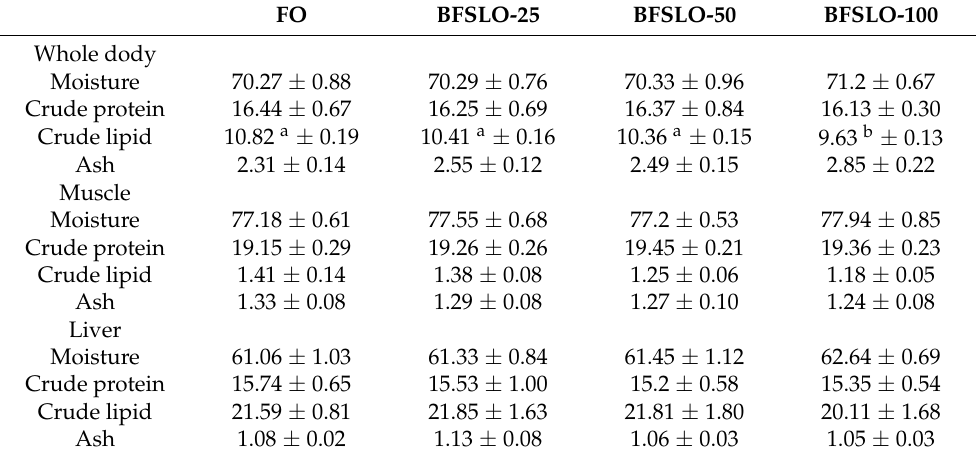
Table 5. Proximate composition (% wet weight) in whole body, muscle and liver of O. macrolepis fed the four experimental diets with different gradient levels of BSFLO (25%, 50% and 100%) replacing FO (control) for eight